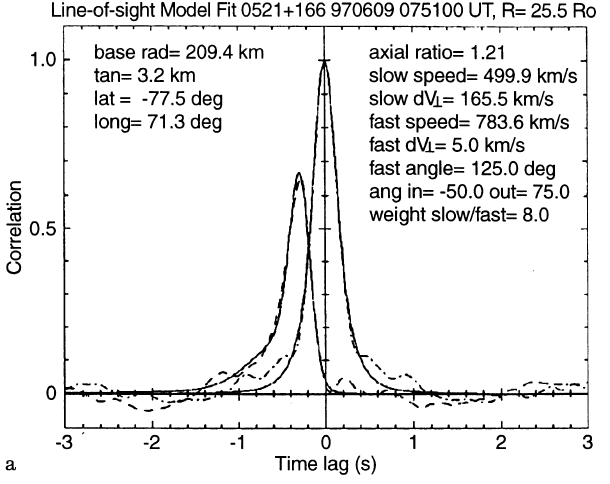
Fig. 2. a Auto- and cross-correlation functions for the observation of 0521+166 on 9 June 1997. The broken lines denote the measured correlation functions and the solid lines the results of fitting using a 2D